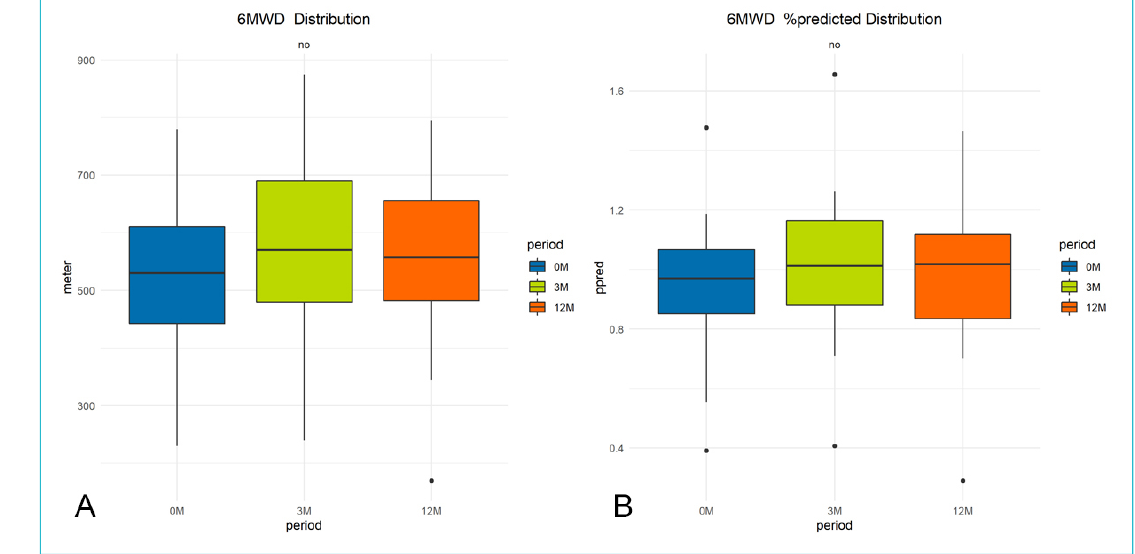
Figure 2: Illustration of changes in physical performance: group mean changes in (a) 6MWD (meters), (b) percentage predicted norm (%). No statistically significant changes in any of the three parameters over time (p